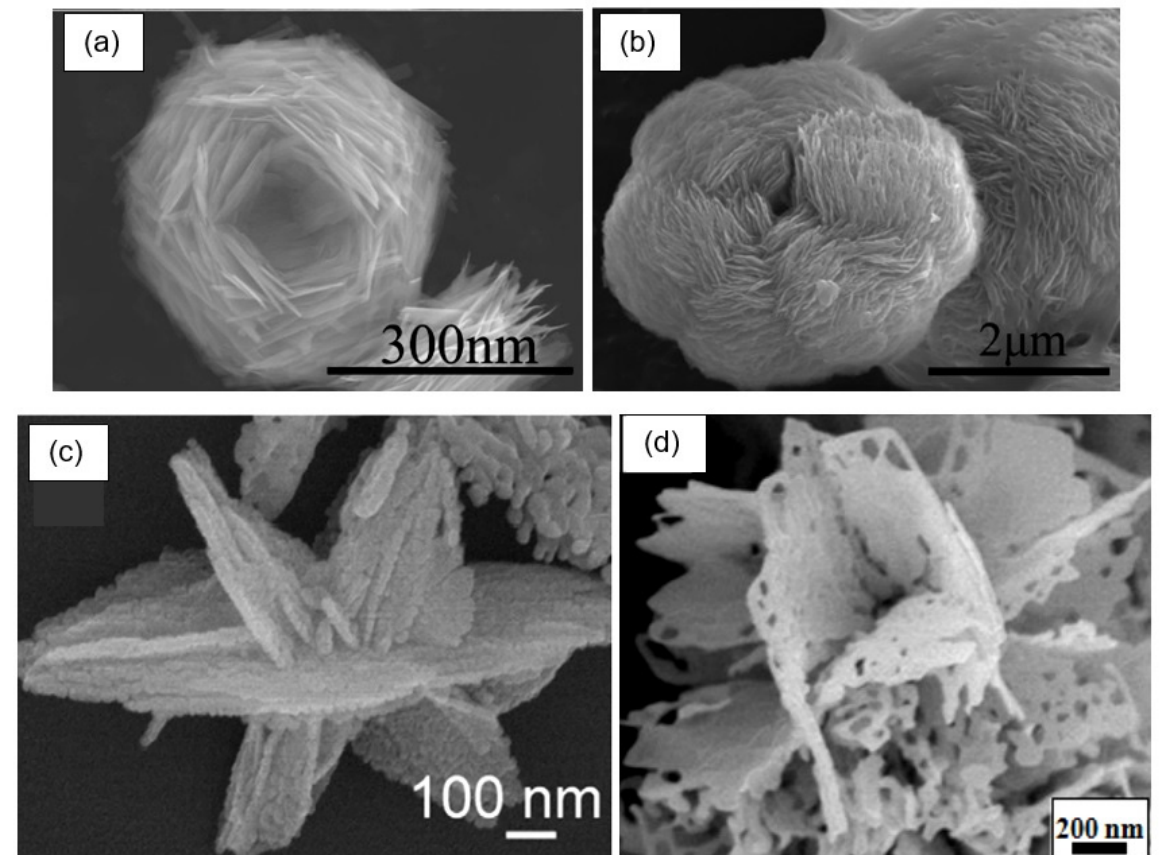
Figure 19. Varieties of 3D structures: ( a , b ) SEM images of nestlike 3D ZnO porous structures synthesized at different temperatures. Reprinted with permission from [145]. Copyright 2012: ACS; ( c ) FE ‐ SEM images of In 2 O 3 hierarchical nanostructure. Reprinted with permission from [102]. Copyright 2012: Elsevier; ( d ) SEM image of porous flowerlike SnO 2 nanostructures. Reprinted with permission from [146]. Copyright 2015: Elsevier.